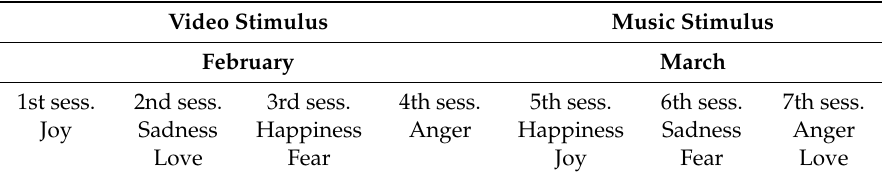
Table 1. Temporary distribution of data collection sessions